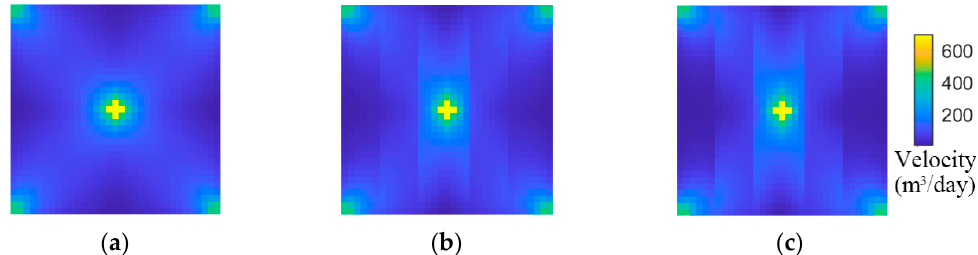
Figure 14. Fluid velocity profiles under different lateral permeability contrasts. ( a ) PC = 5; ( b ) PC = 20; ( c ) PC = 30.